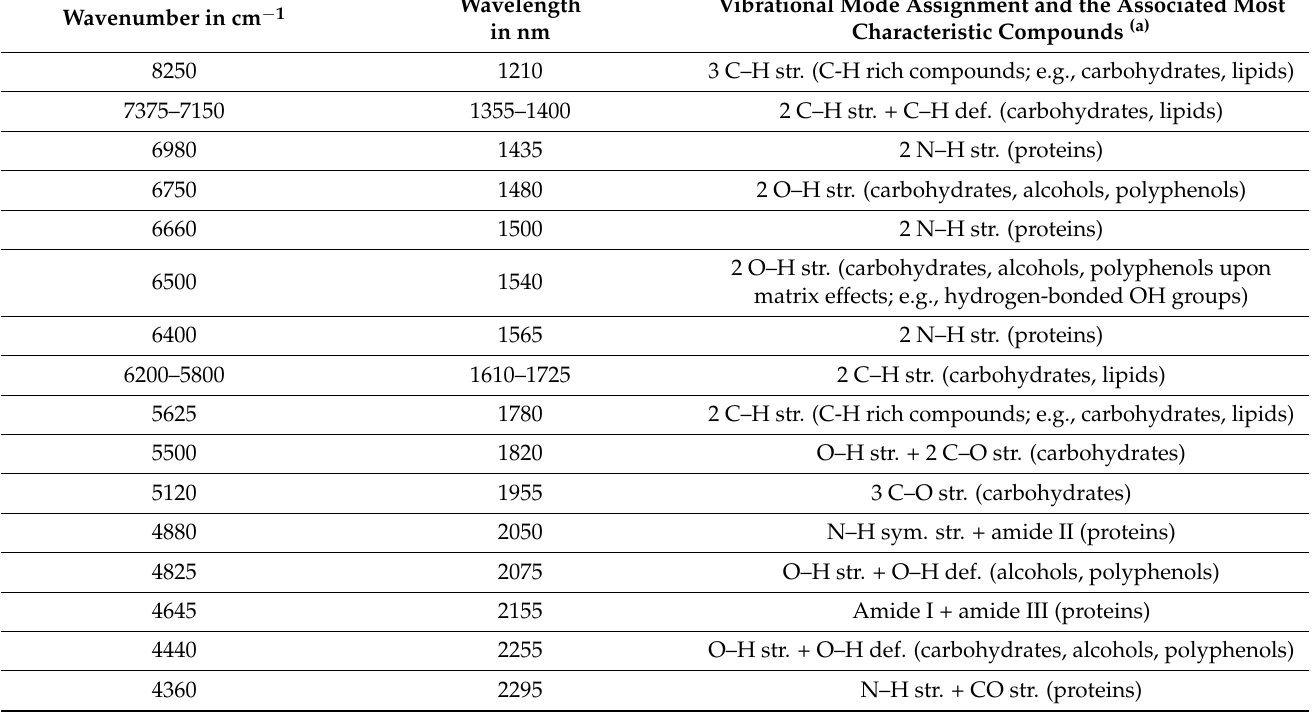
Table 2. Approximate positions of NIR bands of the major classes of chemical compounds commonly present in foodstuffs (excluding water). Reproduced (CC-BY 4.0 license) from [29]. Vibrational Mode Assignment and the Associated